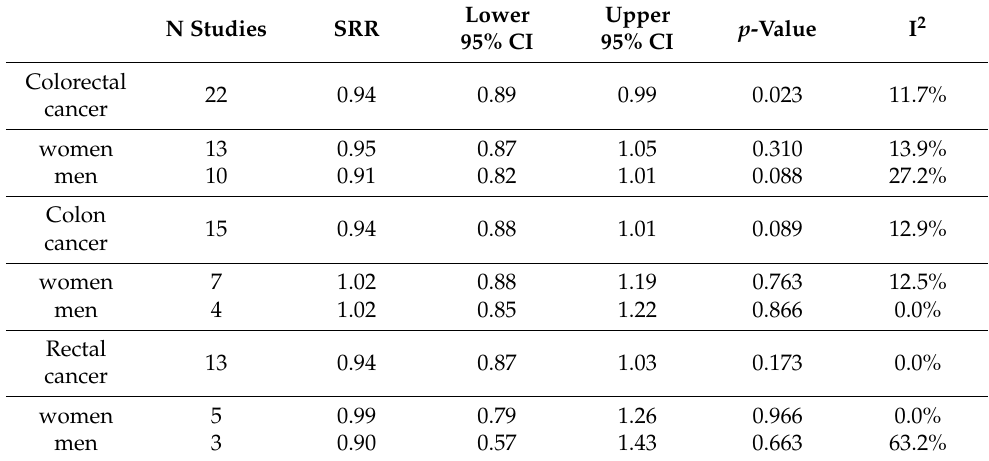
SRR: summary relative risk. CI: confidence intervals.